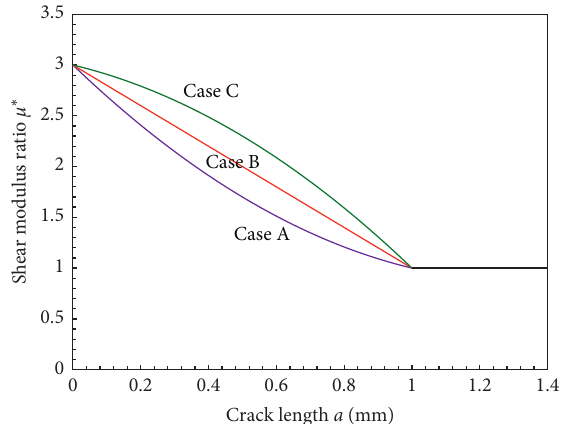
Figure 9: Variation of shear modulus ratio μ ∗ with crack length a.